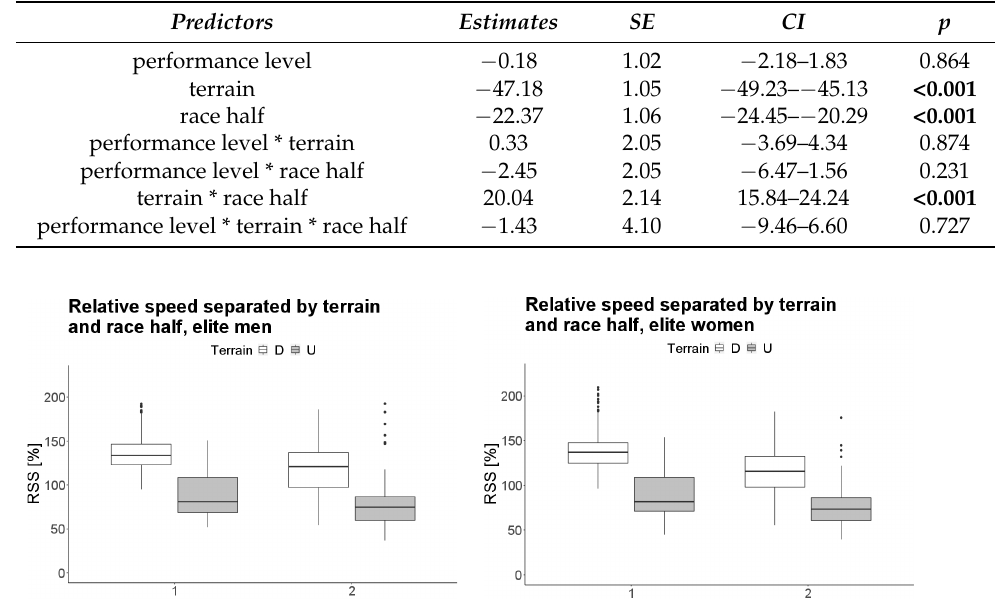
Table 3. Linear mixed effect model output for the top 10 women; significant results are highlighted in bold.